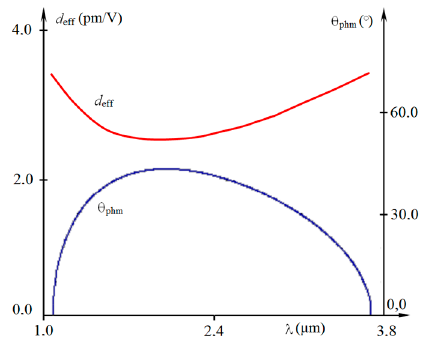
Figure 3. Distributions of phase-matching angle θ and d eff coefficient versus wavelength for SHG in KTP crystal with ( sff ) = ( fsf ) type of interaction.